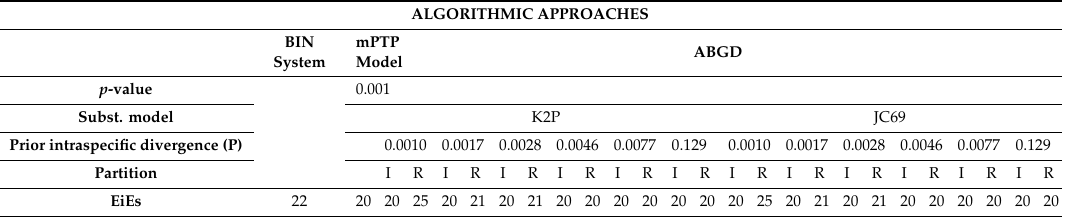
Table 3. Evolutionary independent entities recovered from the COI sequences with the three di ff erent delimitation algorithms. Relative gap (X) of 1.1, minimal intraspecific distance (Pmin) of 0.001, maximal intraspecific distance (Pmax) of 0.1, K2P [70], and JC69 (Jukes-Cantor) [75] were selected as distance metrics. I = Initial partition, R = Recursive partition. EiEs = Evolutionary Independent